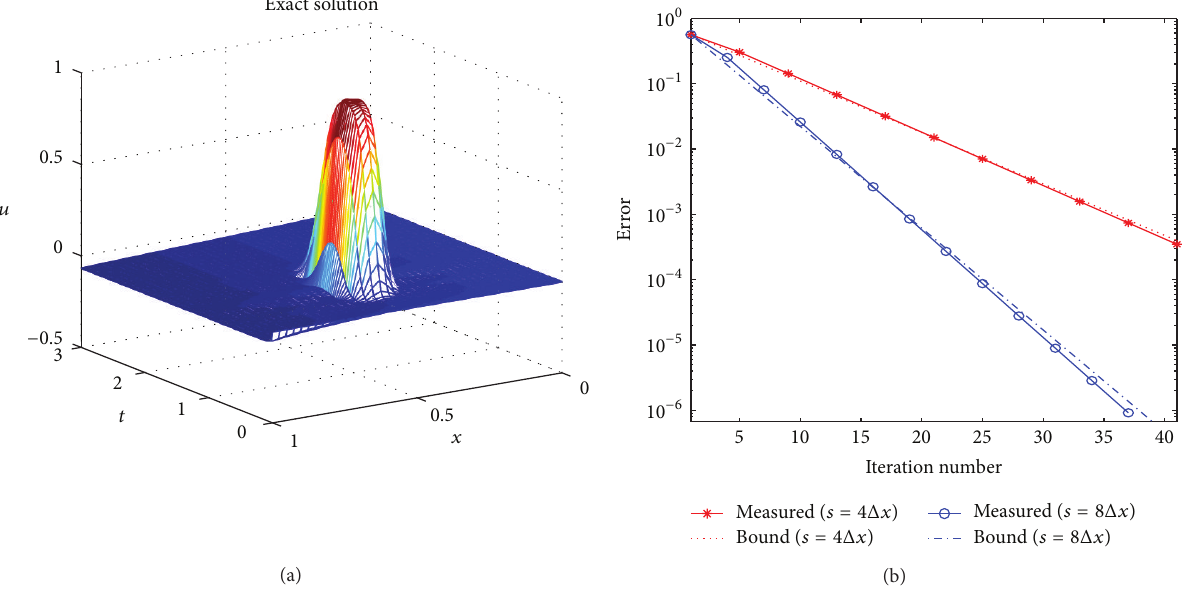
Figure 2: (a) The profile of 𝑢(𝑥,𝑡) on domain (𝑥,𝑡) ∈ [0, 1] × [0, 3] . (b) Convergence rate together with the theoretical linear bound of the SWR algorithm with two different overlap